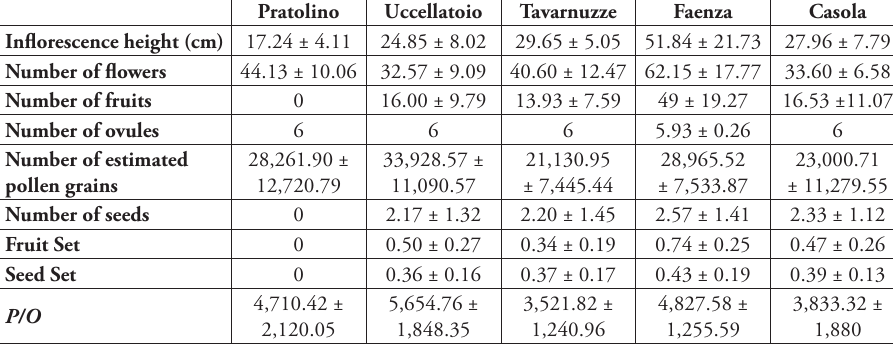
Table 2. Reproductive parameters measured in the five studied populations of Bellevalia webbiana . The measurements are reported as mean value ± standard